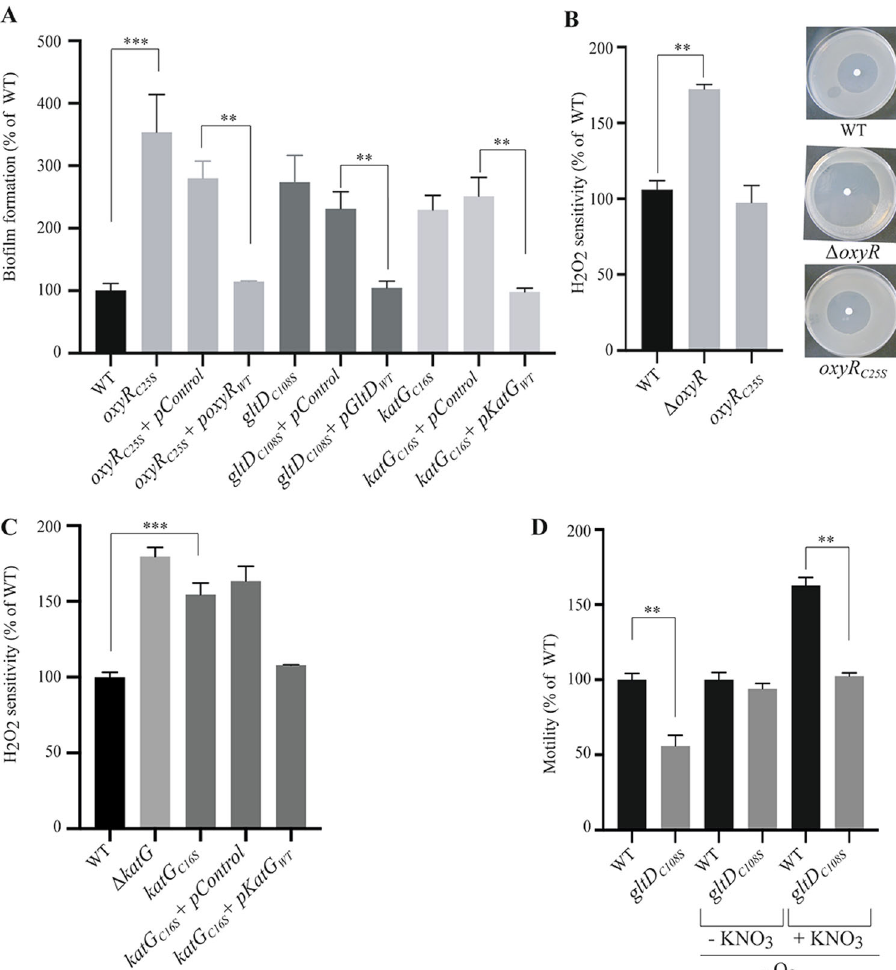
Fig. 5 Impairing S -nitrosylation status of OxyR, KatG, and GltD affects bio fi lm-associated phenotypes. A Bio fi lms of E. coli WT, oxyR C25S, katG C16S , and gltD C108S mutants, complemented or not with the corresponding plasmid-based allele or empty vector, were grown in continuous- fl ow microfermenters for 24 h in LB medium before quantifying the bio fi lm biomass. The level of bio fi lm formed by the WT strain was set to 100%. B Sensitivity to H 2 O 2 oxidative stress of an oxyR C25S mutant compared to the WT and Δ oxyR mutant. The distance of growth inhibition from the edge of the disk to the edge of the growth zone was measured and was set to 100% for the WT strain. C Increased sensitivity to oxidative stress of katG C16S mutant. The sensitivities to H 2 O 2 of E. coli WT and katG C16S mutant complemented with corresponding plasmid-based allele or empty vector were compared. The distance from the edge of the disk to the edge of the growth zone was measured and was set to 100% for the WT strain. D S -nitrosylation-dependent decreased motility of gltD C108S mutant. The motility of E. coli WT and gltD C108S mutant were compared in aerobic conditions and in anaerobic conditions in presence of KNO 3 . Assays were performed on 0.3% agar plates and incubated overnight at 30 °C. All experiments were performed in triplicate, mean values are reported and error bars represent standard deviations. ** p ≤ 0.05, *** p ≤ 0.01. See also Figs. S2, S5 and